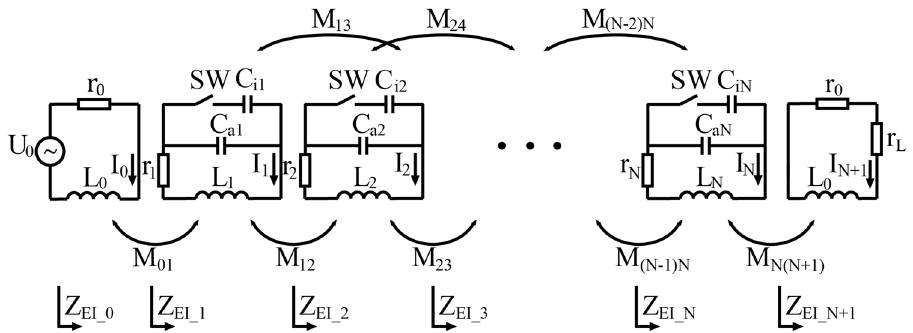
Figure 2. The equivalent circuit diagram of a power transfer